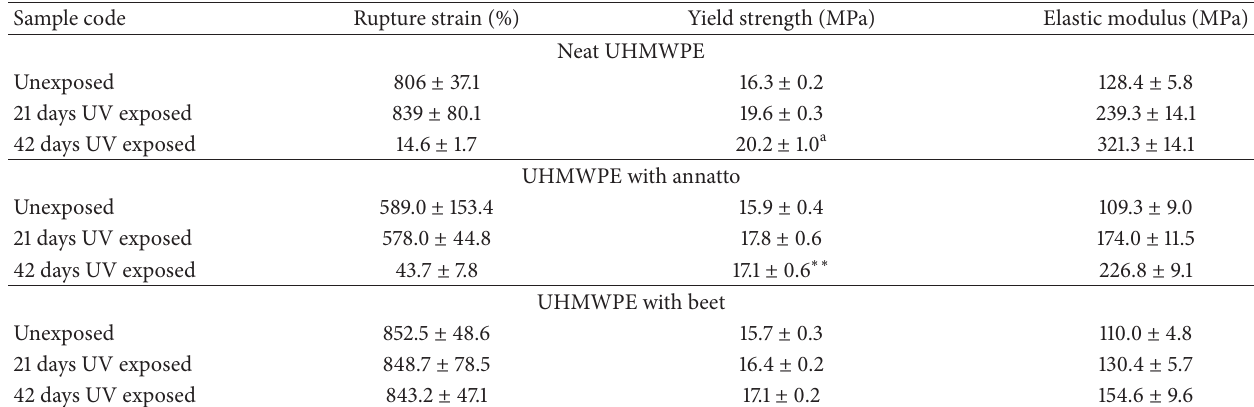
Table 2: Properties obtained in tensile tests.